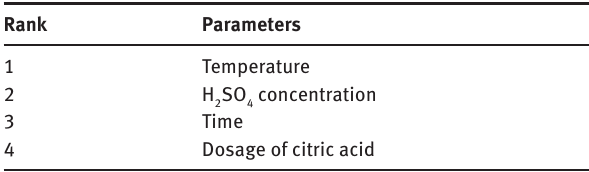
Table 6: Significance rank of different factors on manganese extraction under microwave